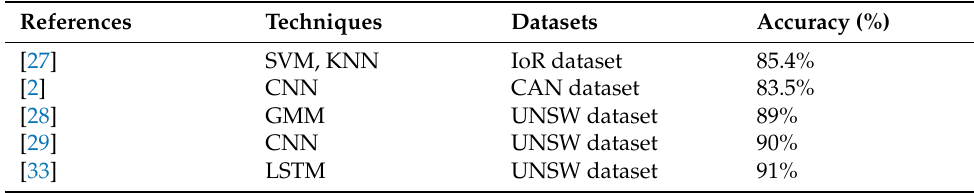
Table 1. Comparative Analysis of Existing